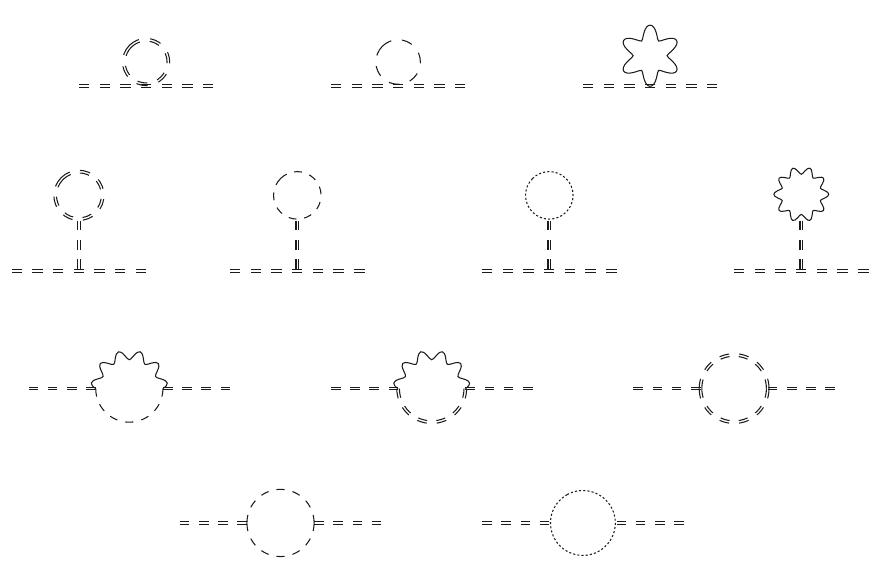
Figure 6 . One-loop diagrams for the dark-Higgs self-energy in Feynman gauge. Double-dashed lines stand for the dark Higgs, dashed lines for the Goldstone boson, wiggly lines for the gauge boson and dotted lines for the ghost